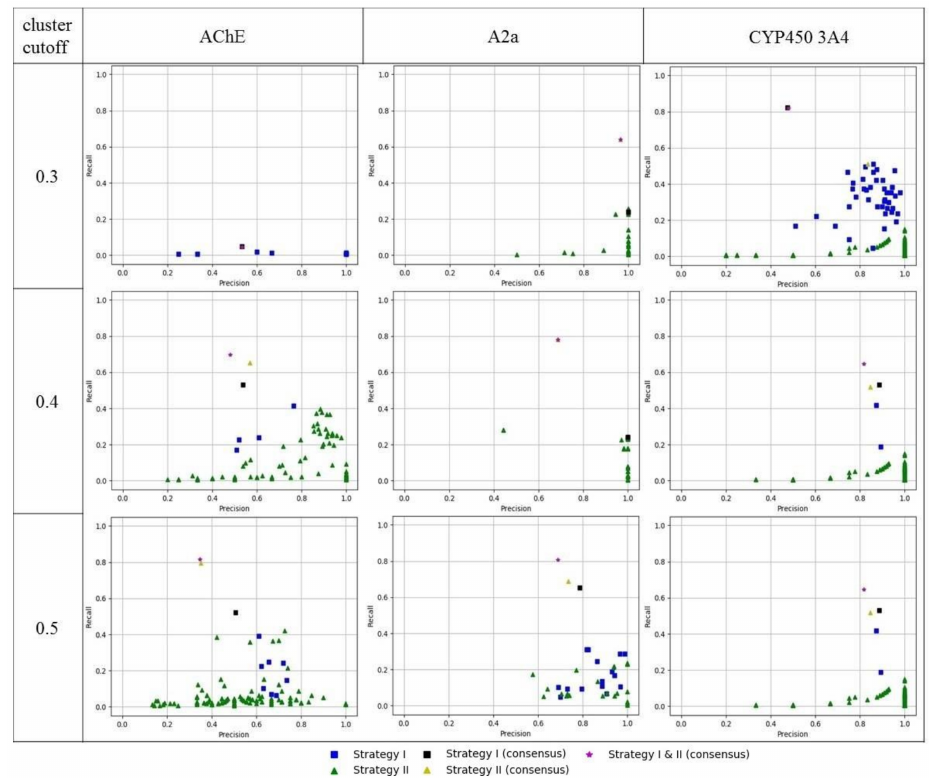
Figure 7. Precision and recall of obtained 3D ligand-based pharmacophore models.